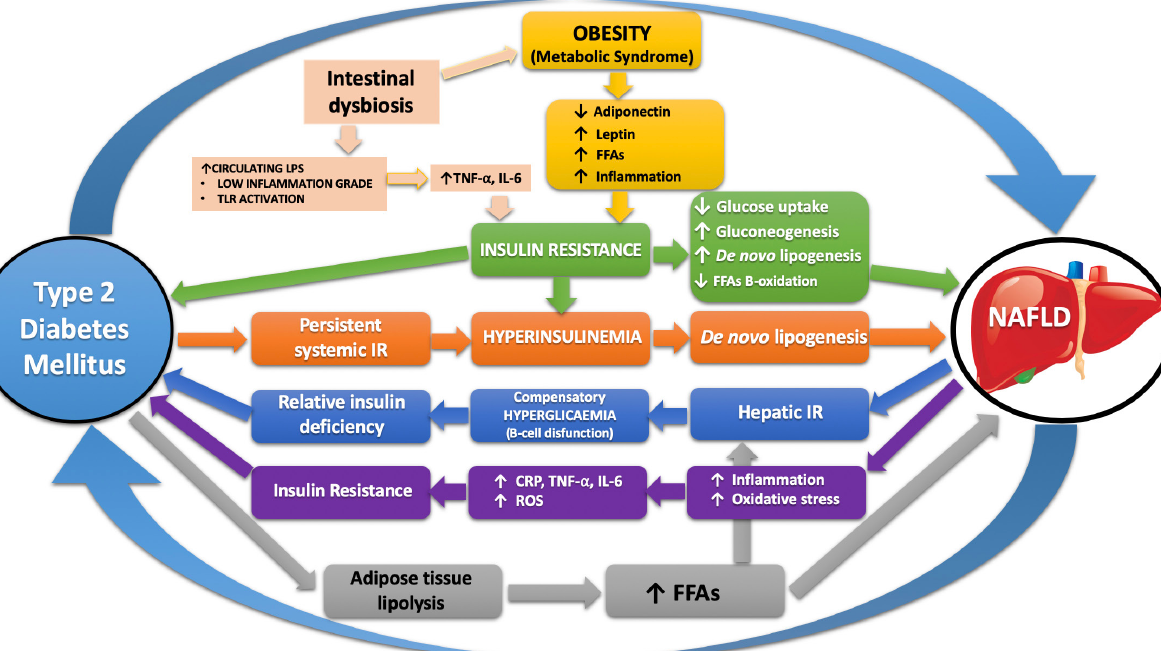
: tumor necrosis factor; IL-6: inteleukine-6; ROS: ⍺